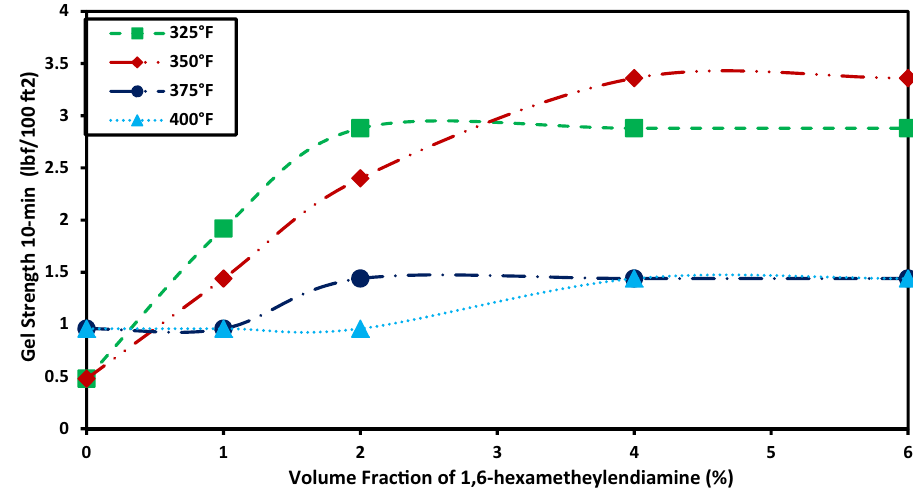
Fig. 12 Effect of the combina- tion of 1,6-hexamethylenedi- amine and PAC on gel strength 10 min